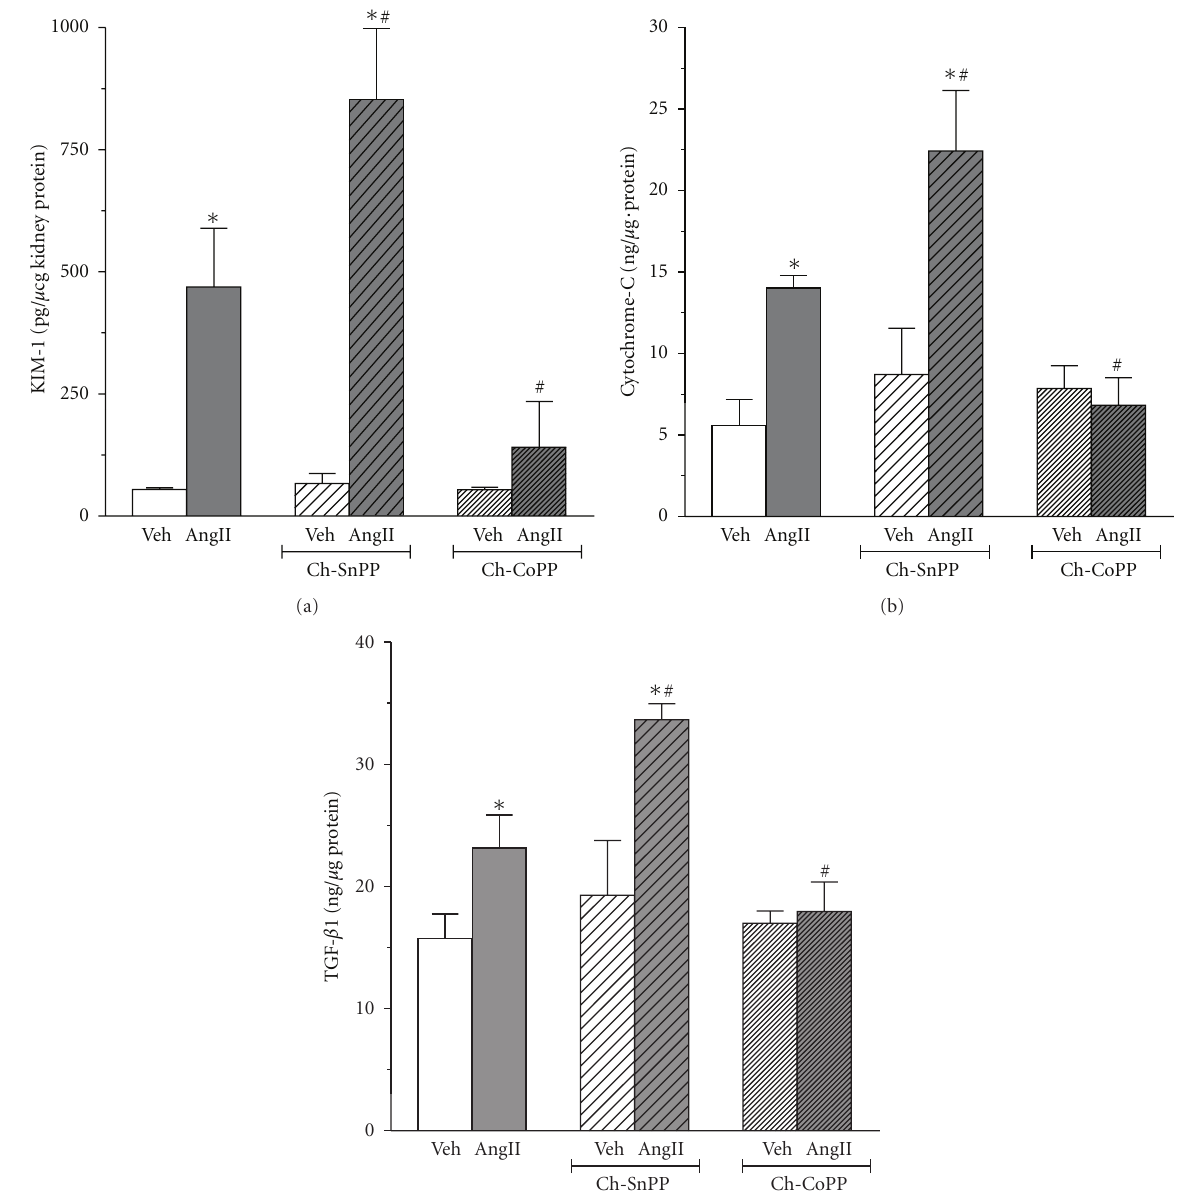
Figure 6: E ff ect of SP-Ang II and HO modulation on renal (a) KIM-1, (b) cytochrome c, and (c) TGF- β 1 expression was estimated in the following groups; Vehicle (Veh) treated ( n = 6), SP-AngII-treated ( n = 6), Chronic SnPP (Ch-SnPP)-treated ( n = 6), SP-AngII/Ch-SnPP- treated ( n = 6), Chronic CoPP (Ch-CoPP)-treated ( n = 6), SP-AngII/Ch-CoPP-treated ( n = 6), ∗ p < 0 . 05 versus. Control, # p < 0 . 05 versus.